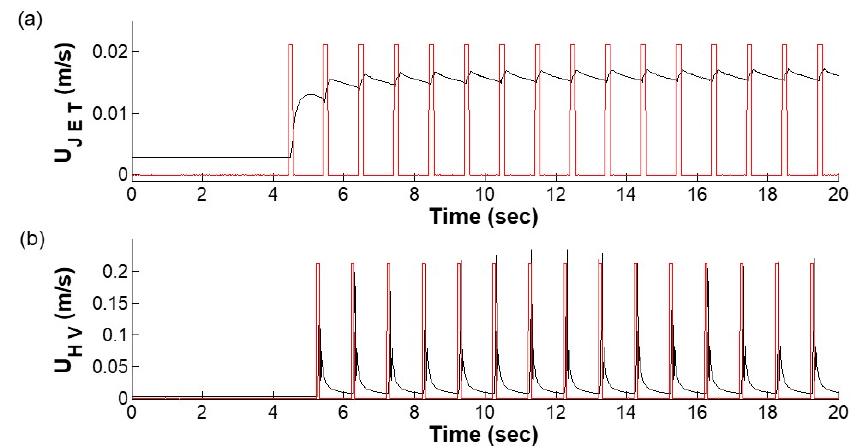
Figure 4. Velocity changes of ( a ) jet ( u Jet ) and ( b ) hairpin vortex ( u HV ) in still water. The solid line shows the velocity change and the dotted line shows the timing of the pinch valve.